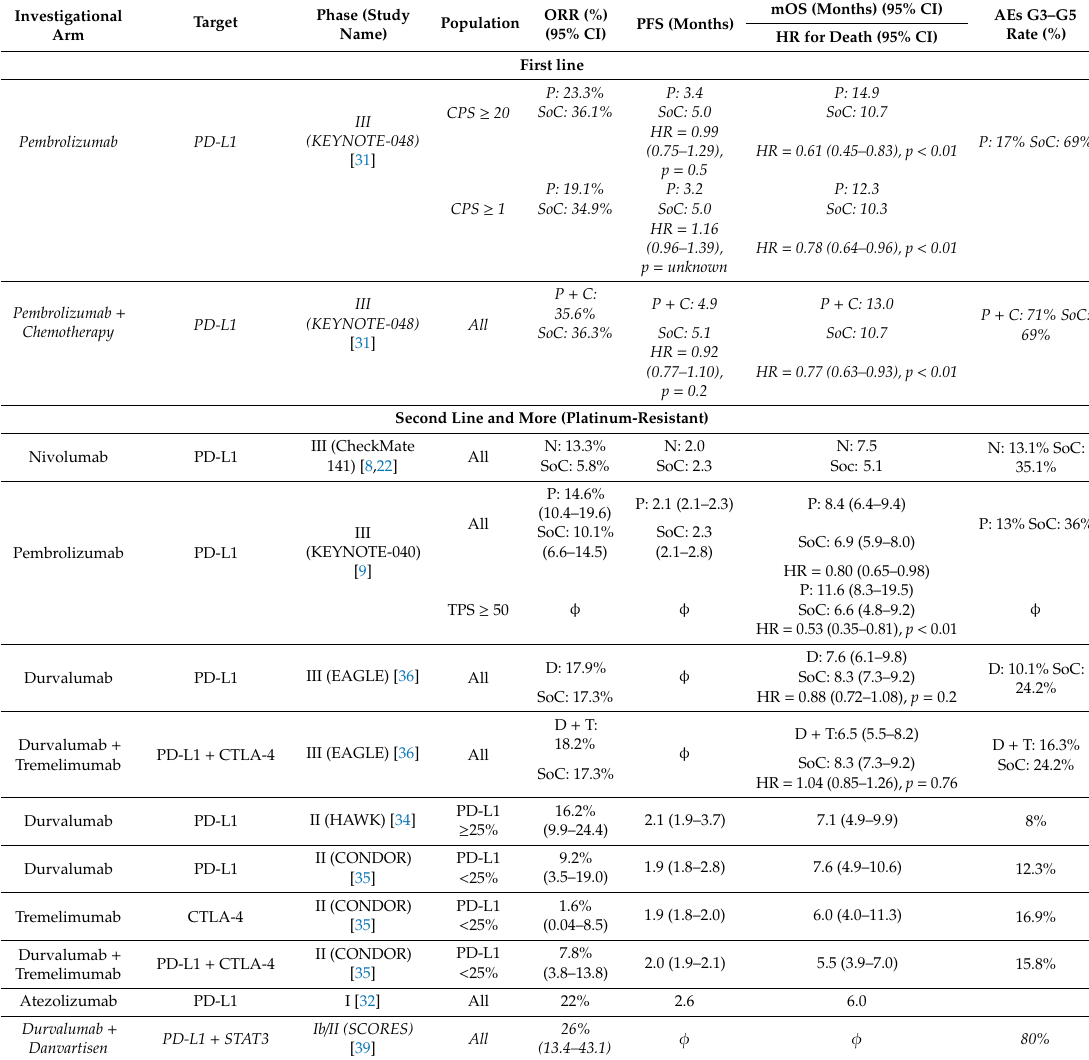
Table 1. Immunotherapeutic agent studied in recurrent / metastatic (R / M) head and neck squamous cell carcinoma